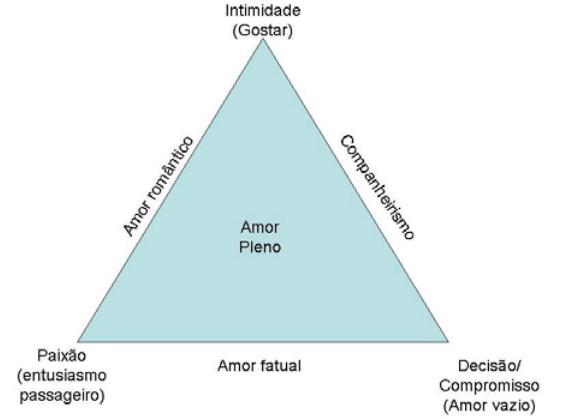
Figura 1. O triângulo do amor de Sternberg